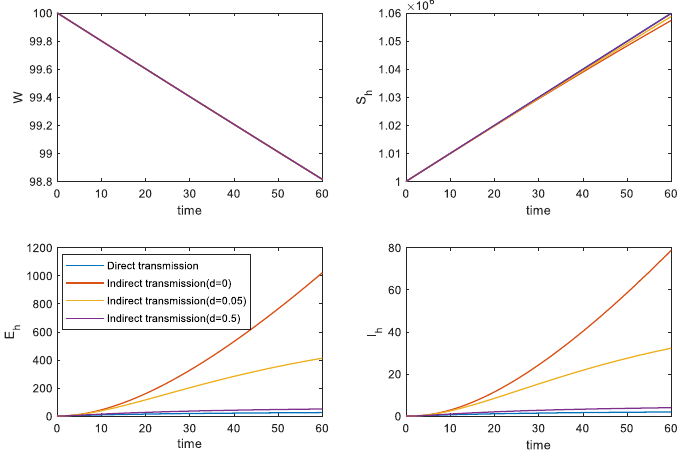
Figure 11. Changes in the numbers of W , S h , E h , and I h with different d and d w = 0.9 in model 2.